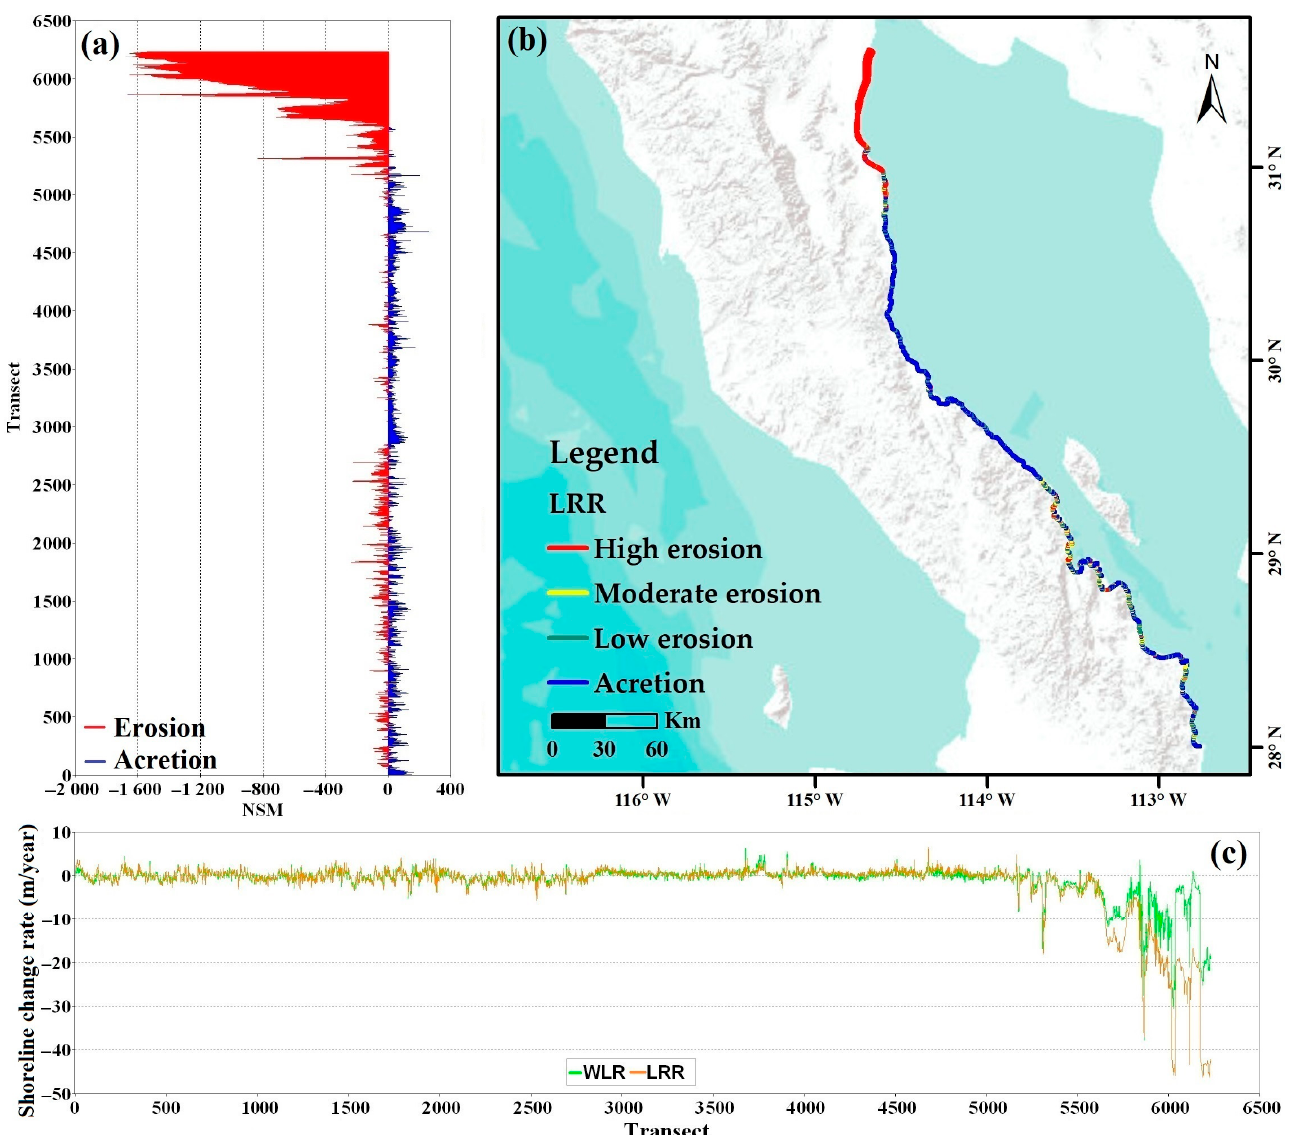
Figure 7. Shoreline dynamics and evaluation, ( a ) NSM (m), ( b ) LRR (m/year), and ( c ) WLR (m/year) for Baja California.